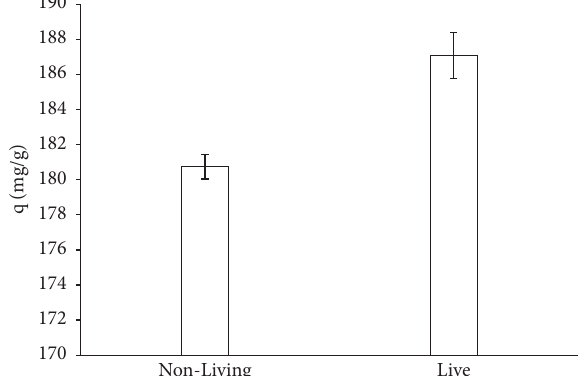
Figure 6: Comparison of Pb (II) uptake by nonliving and living biomass of Penicillium notatum